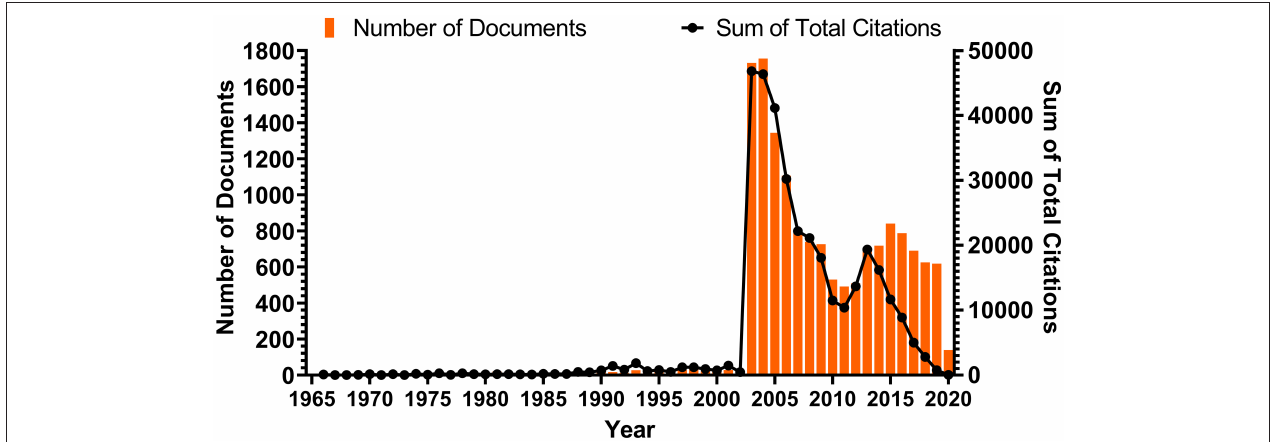
FIGURE 1 | Number of documents published each year and the corresponding citation count of those documents. The bars show the number of documents published each year; the nodes on the line chart represent the sum of total citations that corresponding documents of that year had received. The average number of documents published per year is